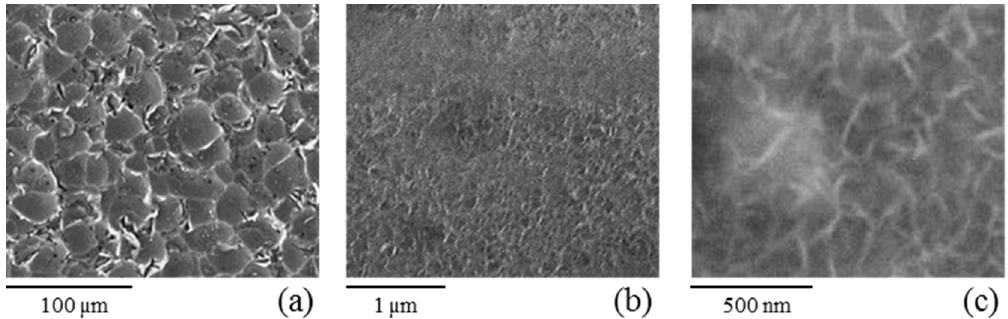
Figure 1. SEM images of superhydrophobic (SHP) surface at different magnifications; ( a ) sandblasted micro-rough surface, secondary electron (SE) at 500×; ( b ) nanostructured pseudo-boehmite surface, SE, 20,000×; ( c ) nanostructured pseudo-boehmite surface, SE, 50,000×.